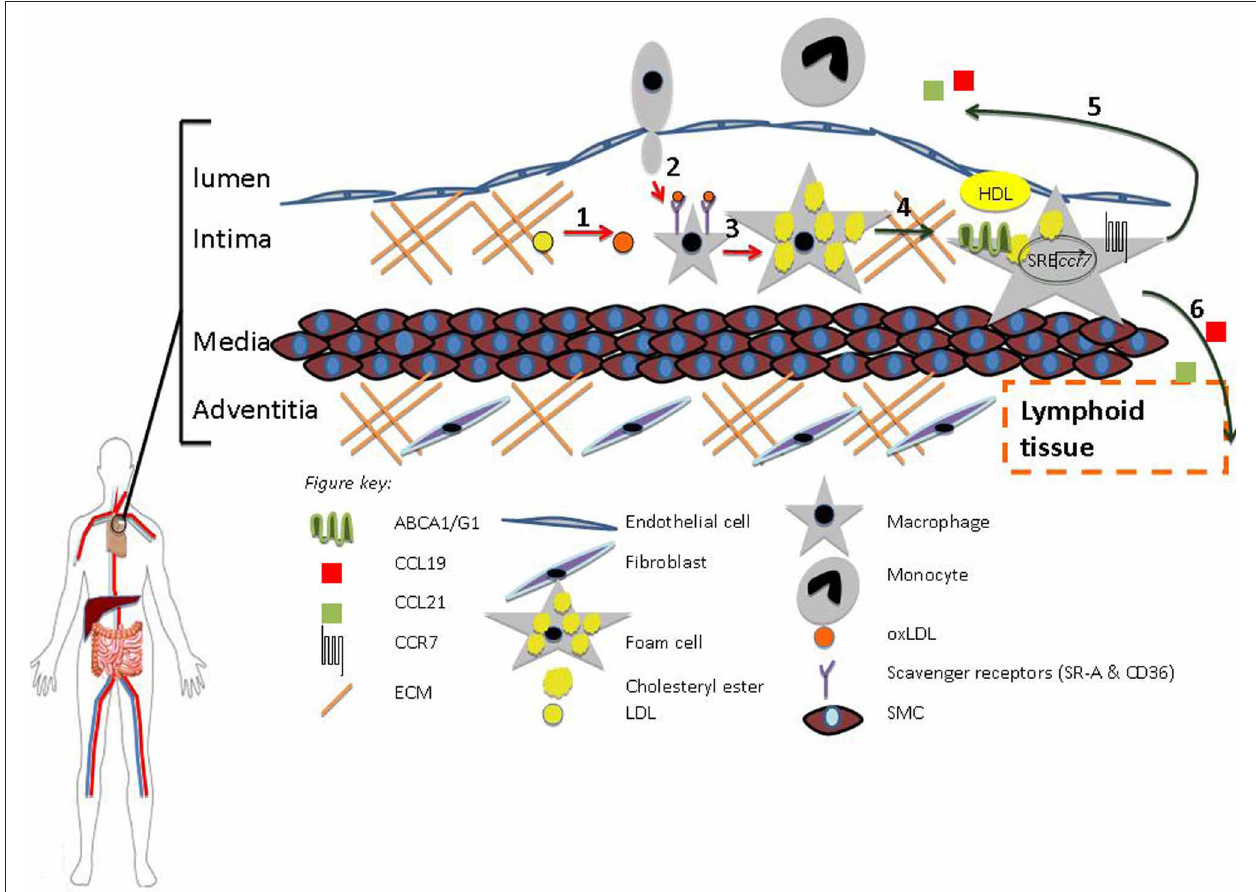
FIGURE 1 | HDL promotes regression. (1) Oxidation (2) Diapedesis (3) Foam Cell formation (4) RCT (5–6) Macrophage Egress from Lesion to Lumen and Adventitia, respectively. HDL can inhibit processes 1–3 (red arrows) and